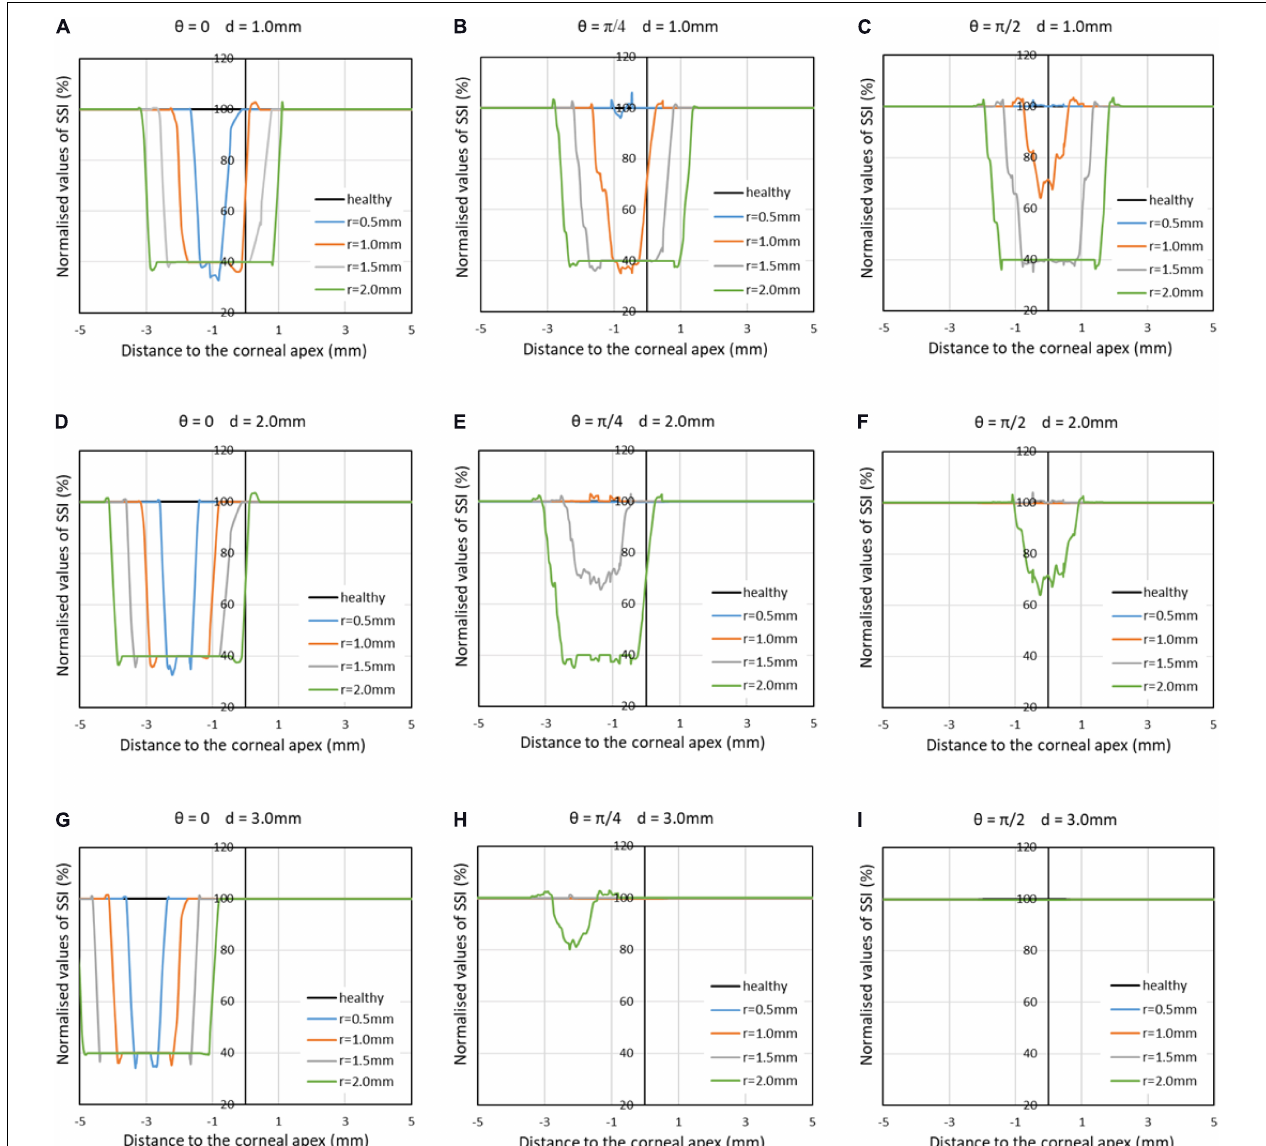
FIGURE 8 | Normalized SSI values along the horizontal central meridian of the cornea for several cases, in which the KC cone had a radius (r) of 0.5, 1.0, 1.5, or 2.0 mm; a distance between cone center and corneal apex (d) of 1.0, 2.0, or 3.0 mm; and an angle ( θ ) of 0 ◦ , 45 ◦ , or 90 ◦ between the horizontal center line of cornea and line from apex to cone center. The max fibril density reduction (60%) was considered in all